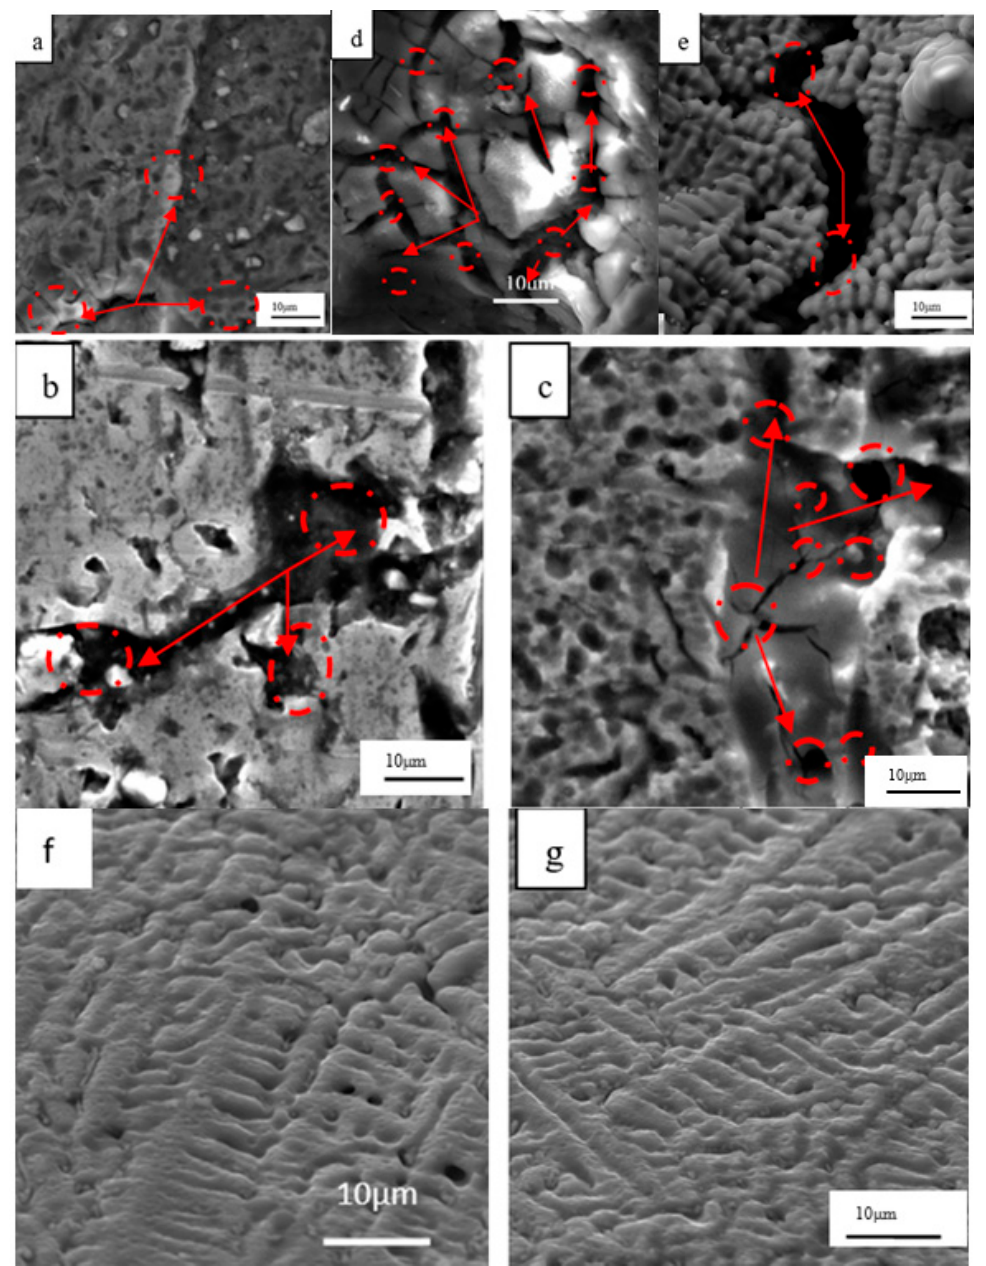
Figure 9. Microscopic image of solidification crack propagation: ( a ) 4 m/min; ( b ) 4.5 m/min; ( c ) 5.0 m/min; ( d ) 5.5 m/min; ( e ) 6 m/min; ( f ) 6.5 m/min; ( g ) 7.0 m/min.